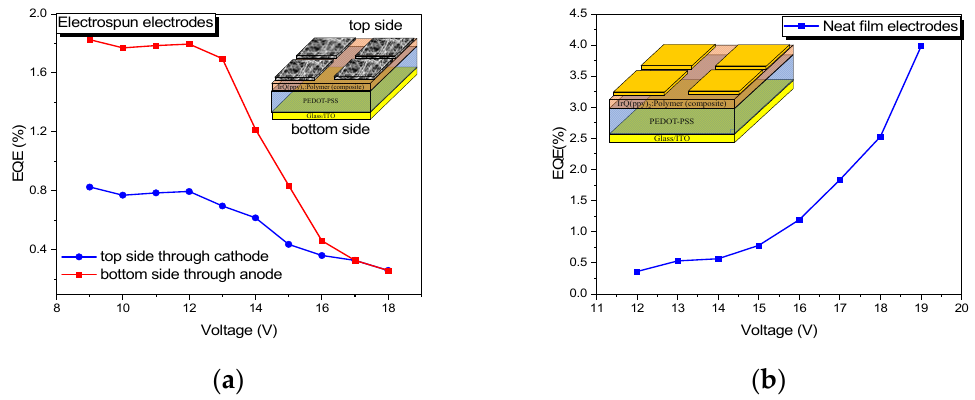
Figure 8. EQE versus the applied voltage for the ( a ) electrospun cathode and ( b ) the neat film cathode.